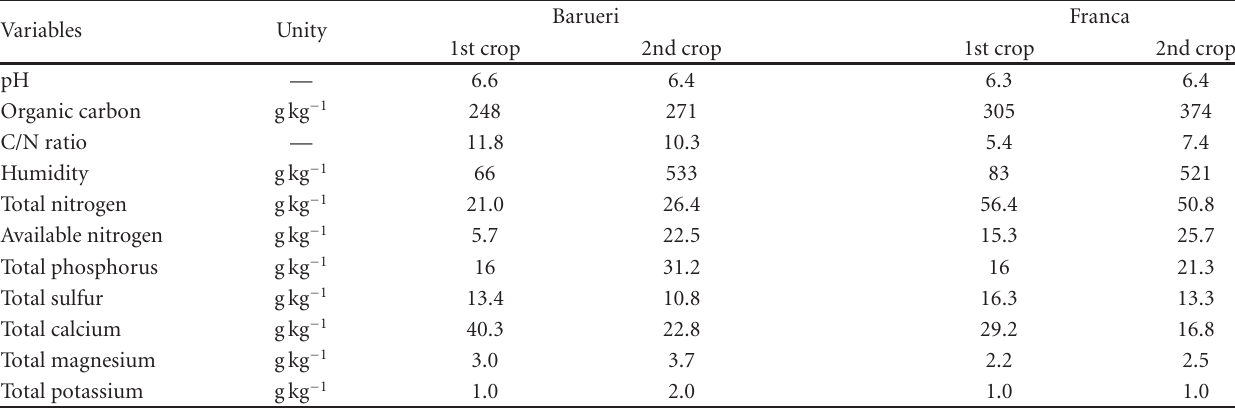
Table 2: Partial chemical analysis of biosolids samples originated from Barueri and Franca cities and used for two crops growth. Barueri Franca Variables Unity 1st crop 2nd crop 1st crop 2nd crop pH — Organic carbon gkg − 1 248 271 305 C/N ratio — Humidity Available